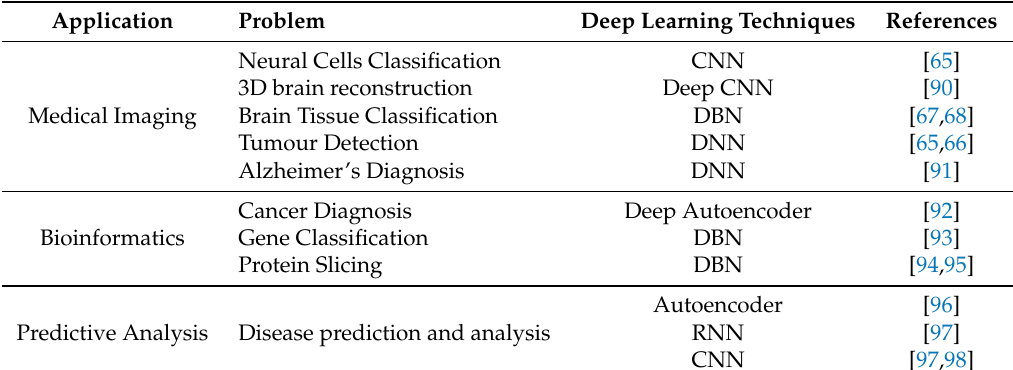
Table 3. Smart health applications with their respective deep learning techniques on medical sensory data. Applications are grouped into three categories: Medical imaging, bioinformatics and predictive analysis. Each application addresses multiple problems on sensed data through various deep learning techniques. DNN, deep neural